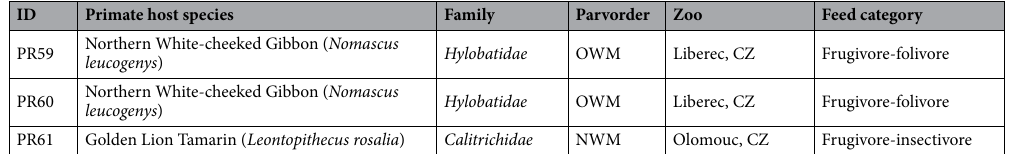
Table 1. List of monkey hosts kept in zoological gardens . General information about primate taxonomy, parvorder and feed classification. Primate general feeders (n = 52) were grouped to 4 individual feed categories based on proportion of dominating feed components – frugivore-omnivore, frugivore-folivore, frugivore- insectivore, and gummivore-insectivore. Zoo, zoological garden; CZ, Czechia; SK, Slovakia; NWM, New World monkey; OWM, Old World monkey.